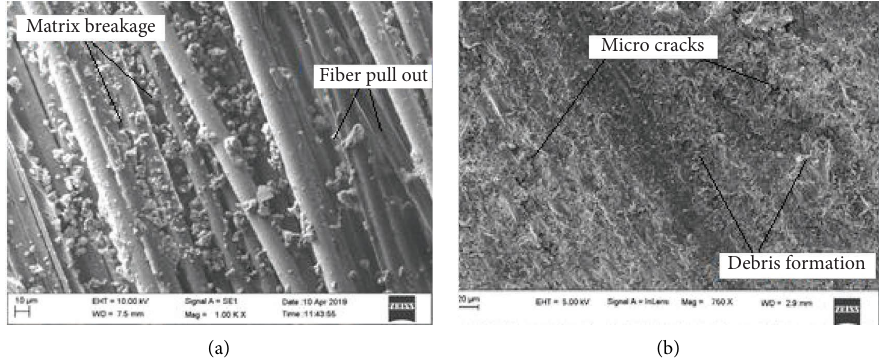
Figure 17: SEM results of wear samples at 2.0% of Al